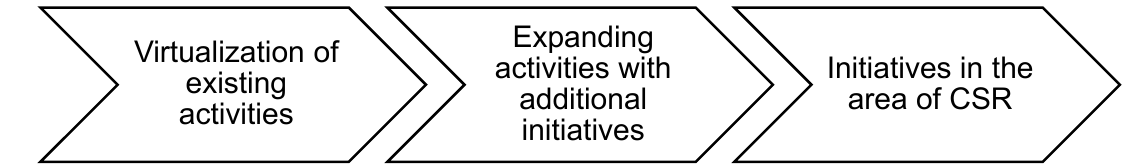
Figure 5. The process of adaptation of cultural institutions to the pandemic conditions. Source: own study.